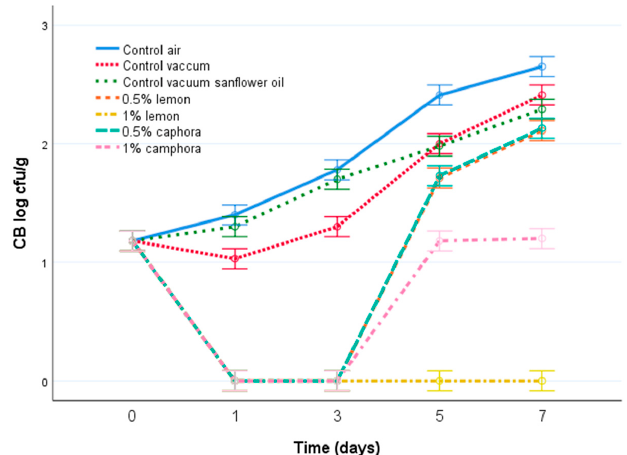
Figure 2. Evolution of counts (log cfu/g) of CB in samples of rainbow trout during 7 days of storage at 4 °C. Air control—aerobically packed control samples; vacuum control—vacuum ‐ packed control samples; vegetable oil control—vacuum ‐ packed control samples treated with sunflower oil; lemon EO 0.5—vacuum ‐ packed samples treated with 0.5% lemon EO; lemon EO 1—vacuum ‐ packed samples treated with 1.0% lemon EO; C. camphora EO 0.5—vacuum ‐ packed samples treated with 0.5% C. camphora EO; and C. camphora EO 1—vacuum ‐ packed samples treated with 1.0% C. camphora EO. Bars denote ± twice the standard error ( p < 0.05).